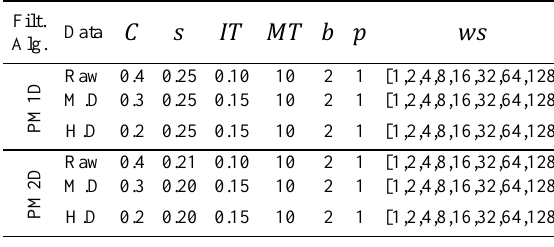
Table 1. The parameters used in the PM1D and PM2D algorithms (M.D stands for medium-density and H.D means high-density) The optimum parameters used in the MLS algorithm are given